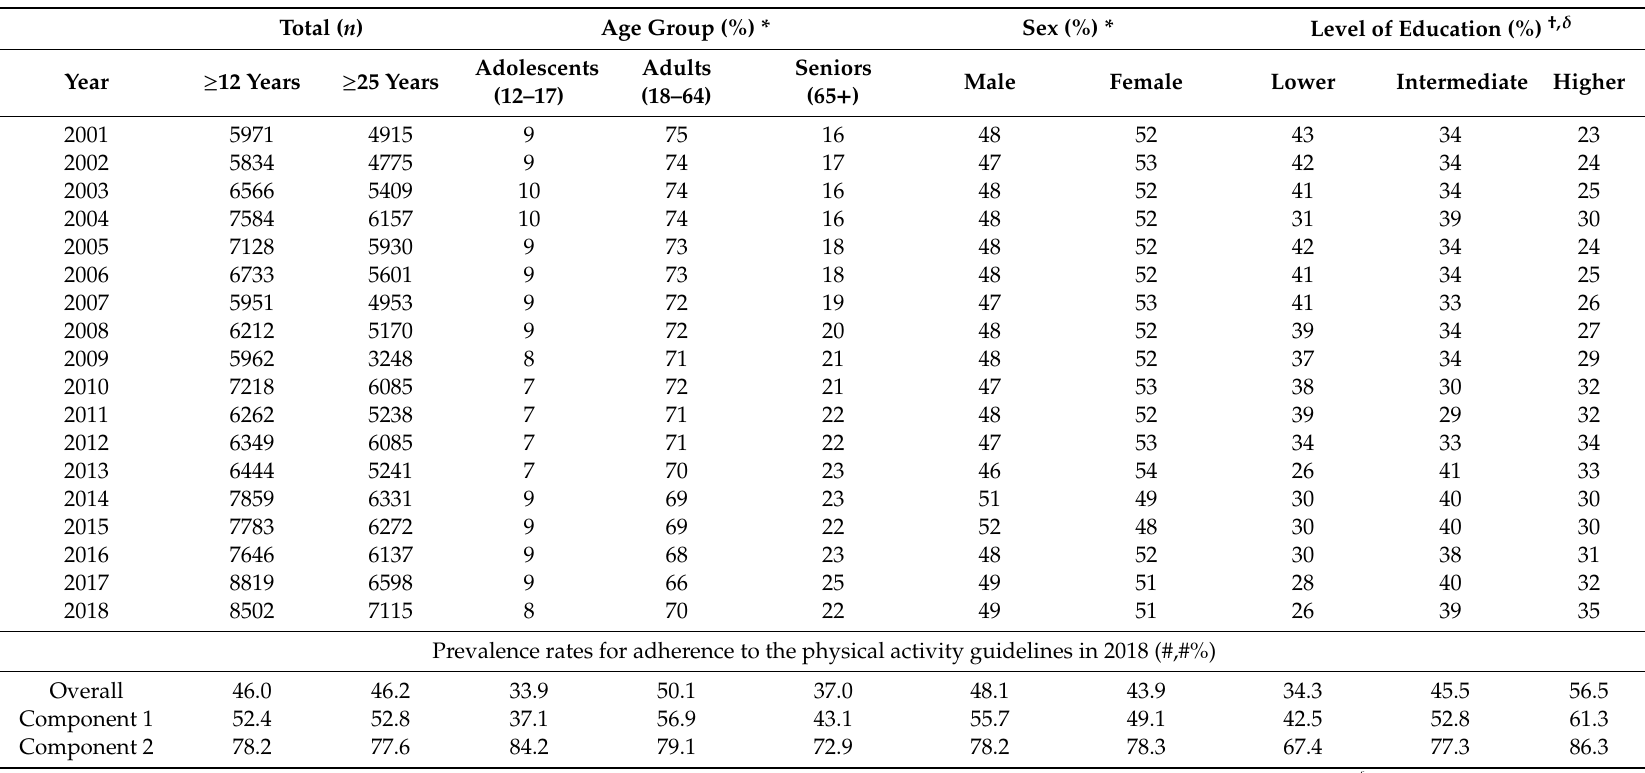
Table 3. Population size ( n ) for each year included in the analysis stratified by age, sex, and by level of education (#%) and the prevalence of adherence to the Dutch physical activity guidelines and components: (1) moderate and vigorous intense physical activity, (2) bone and muscle strengthening activities, for all subgroups